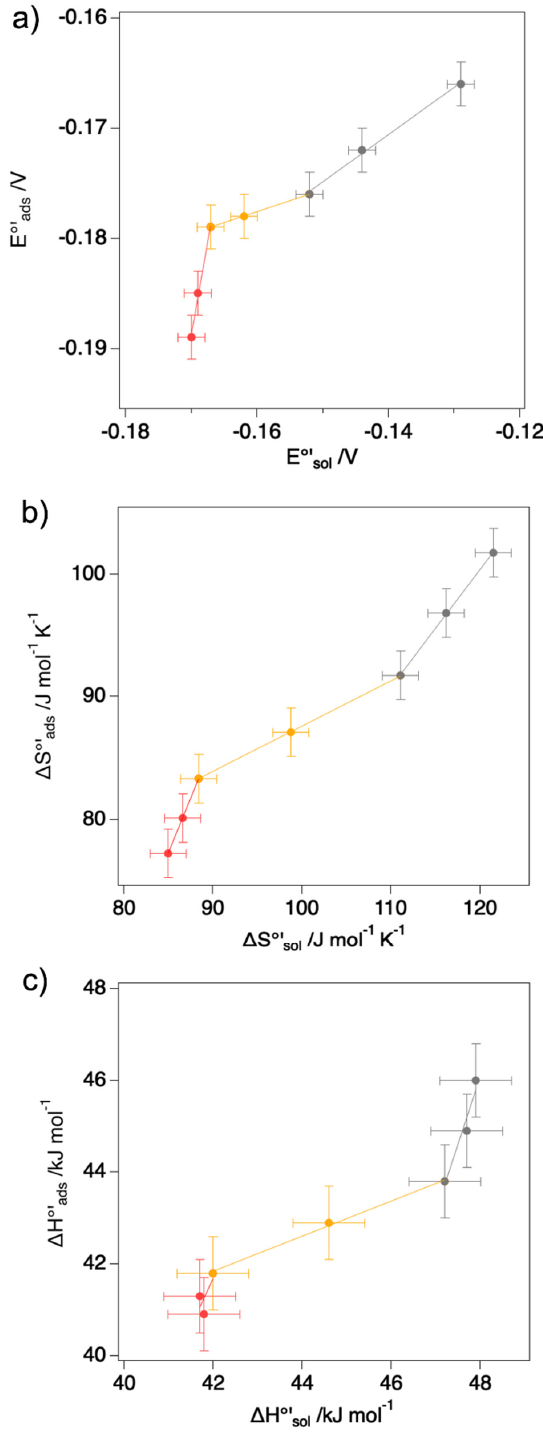
Figure 5. Comparison of thermodynamic parameters (E°’, Δ H°’ rc and Δ S°’ rc in panels ( a – c ), respec- tively) obtained for the adsorbed M80A cytc variant and for the same species in solution at increasing DMSO concentration. Red points refer to 0% and 5% DMSO; orange points refer to 10% and 20% DMSO; gray points to 30%, 40% and 50% DMSO. The data corresponding to the SAM-immobilized proteins are taken from ref. [44]. The red, orange and gray lines are least-squares fits to the data points for %DMSO ≤ 10%, 10% ≤ %DMSO ≤ 30% and DMSO ≥ 30%.